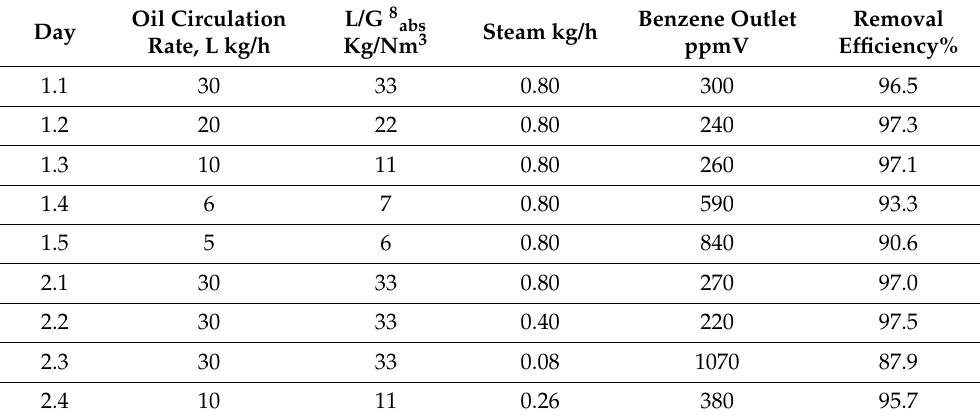
Table 7. Summary of the AREA-1 benzene removal efficiency results. The removal efficiency is based on an average inlet concentration of 8850 ppmV